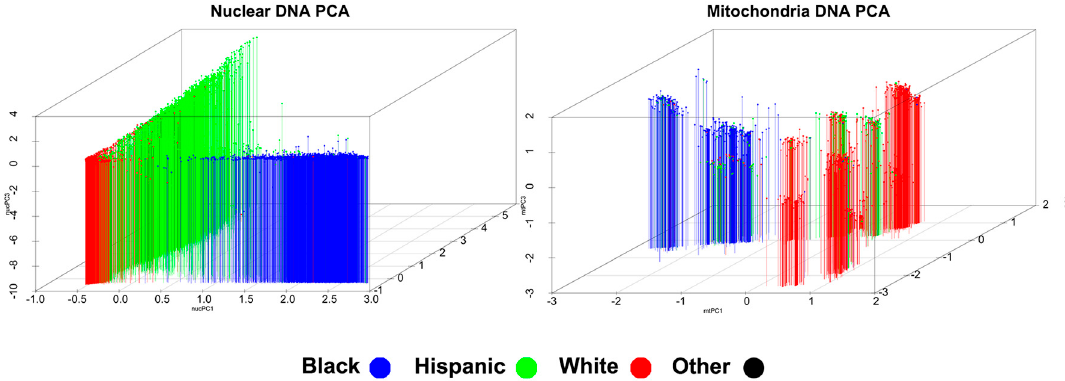
Figure 1. Multi-ethnic principal component analysis on nuclear and mitochondrial single nucleotide polyrmophisms. Each data point represents one individual. Colors are coded by self-reported ethnicity.